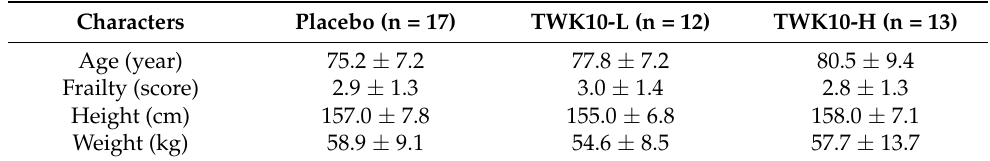
Table 1. Physiological characteristics of